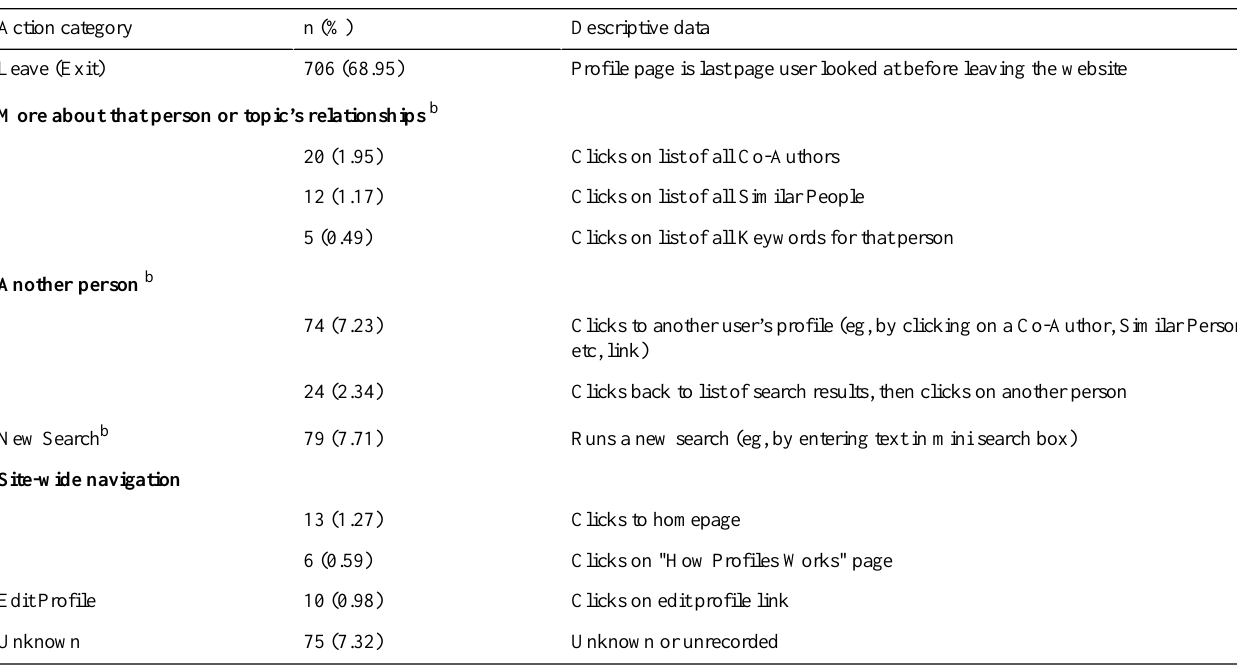
Table 1. Actions taken from a profile page (n=1024). a